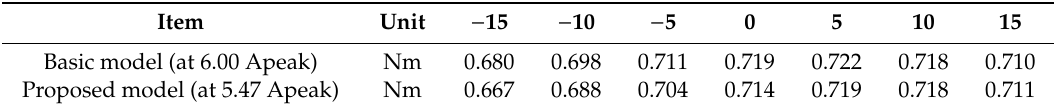
Table 6. Characteristics of torque according to the advance angle.